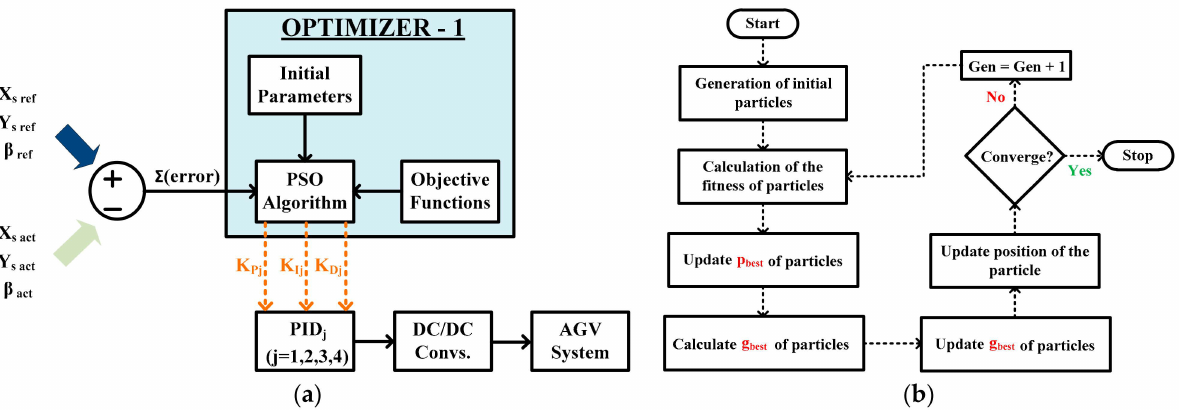
Figure 5. ( a ) PSO-based PID tuning diagram of the AGV’s route-tracking control structure. ( b ) The optimization algorithm of the PSO method.